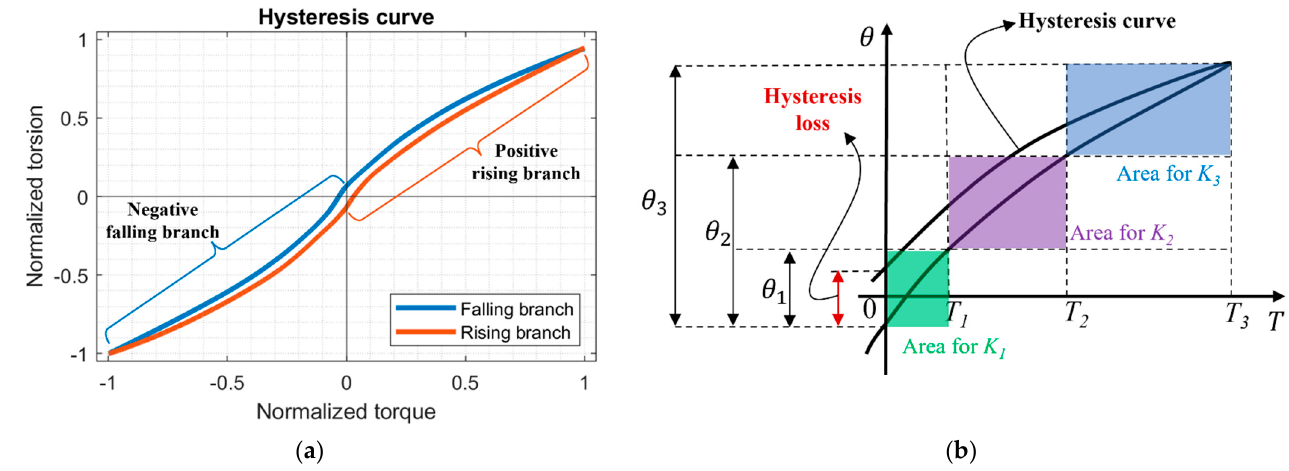
Figure 2. ( a ) Example of a normalized hysteresis curve of a strain wave gear. ( b ) Schematic representation of a hysteresis curve for a piecewise approximation of the gear torsional stiffness.